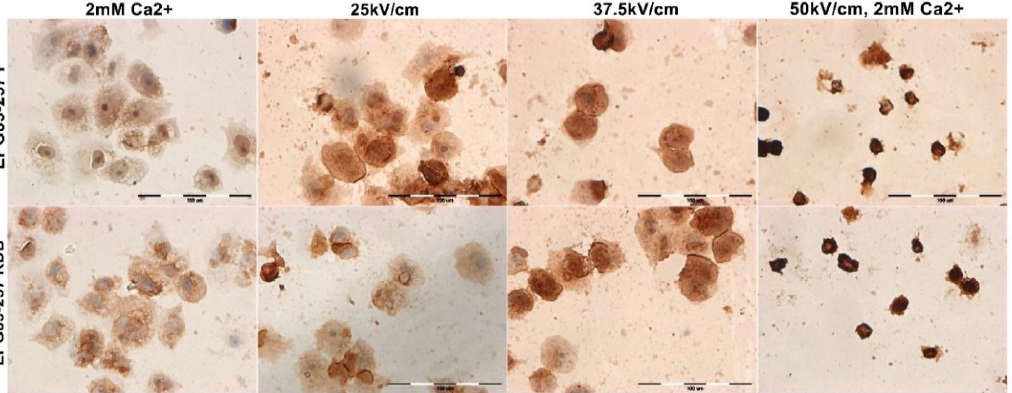
Figure 9. The visualization of AIF protein expression in human gastric cancer cells (P-sensitive, and RDB — resistant) after nsPEF protocols; exemplary microphotographs are shown. Scale bars correspond to 100 µm. Table 1. Immunocytochemical evaluation of AIF (apoptosis inducing factor) in gastric cancer cells after nsPEFs therapy with calcium ions.